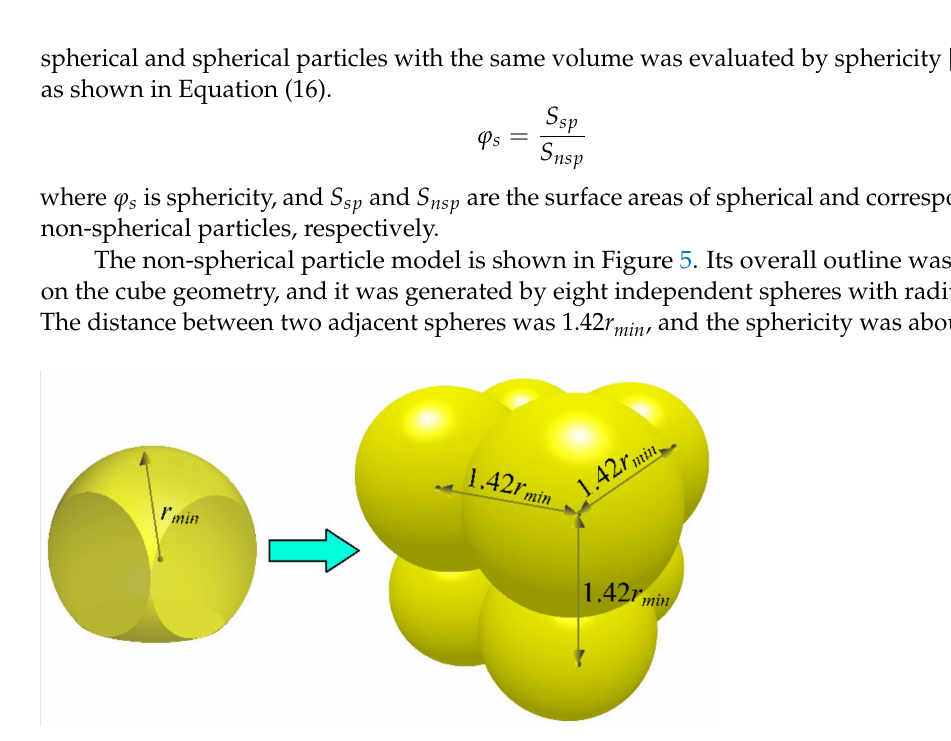
Figure 5. Non-spherical particle model.